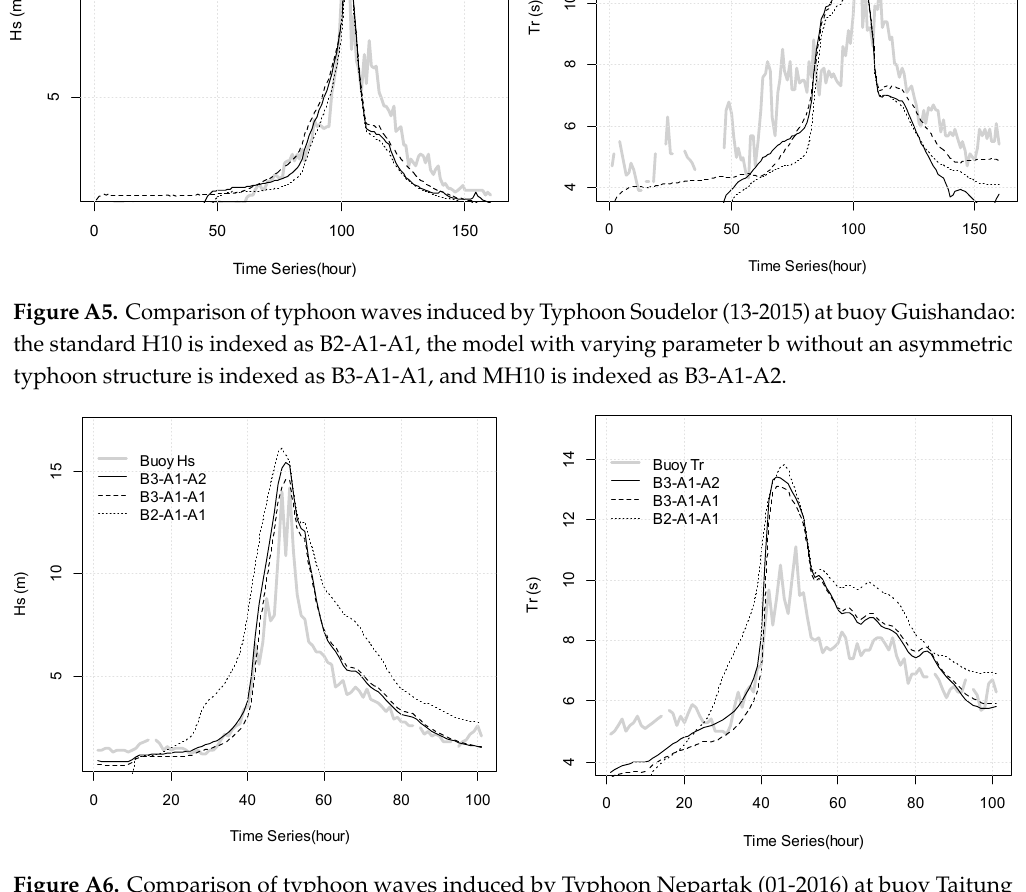
Figure A8. Comparison of typhoon waves induced by Typhoon Meranti (14-2016) at buoy Taitung Open Ocean: the standard H10 is indexed as B2-A1-A1, the model with varying parameter b without an asymmetric typhoon structure is indexed as B3-A1-A1, and MH10 is indexed as B3-A1-A2.